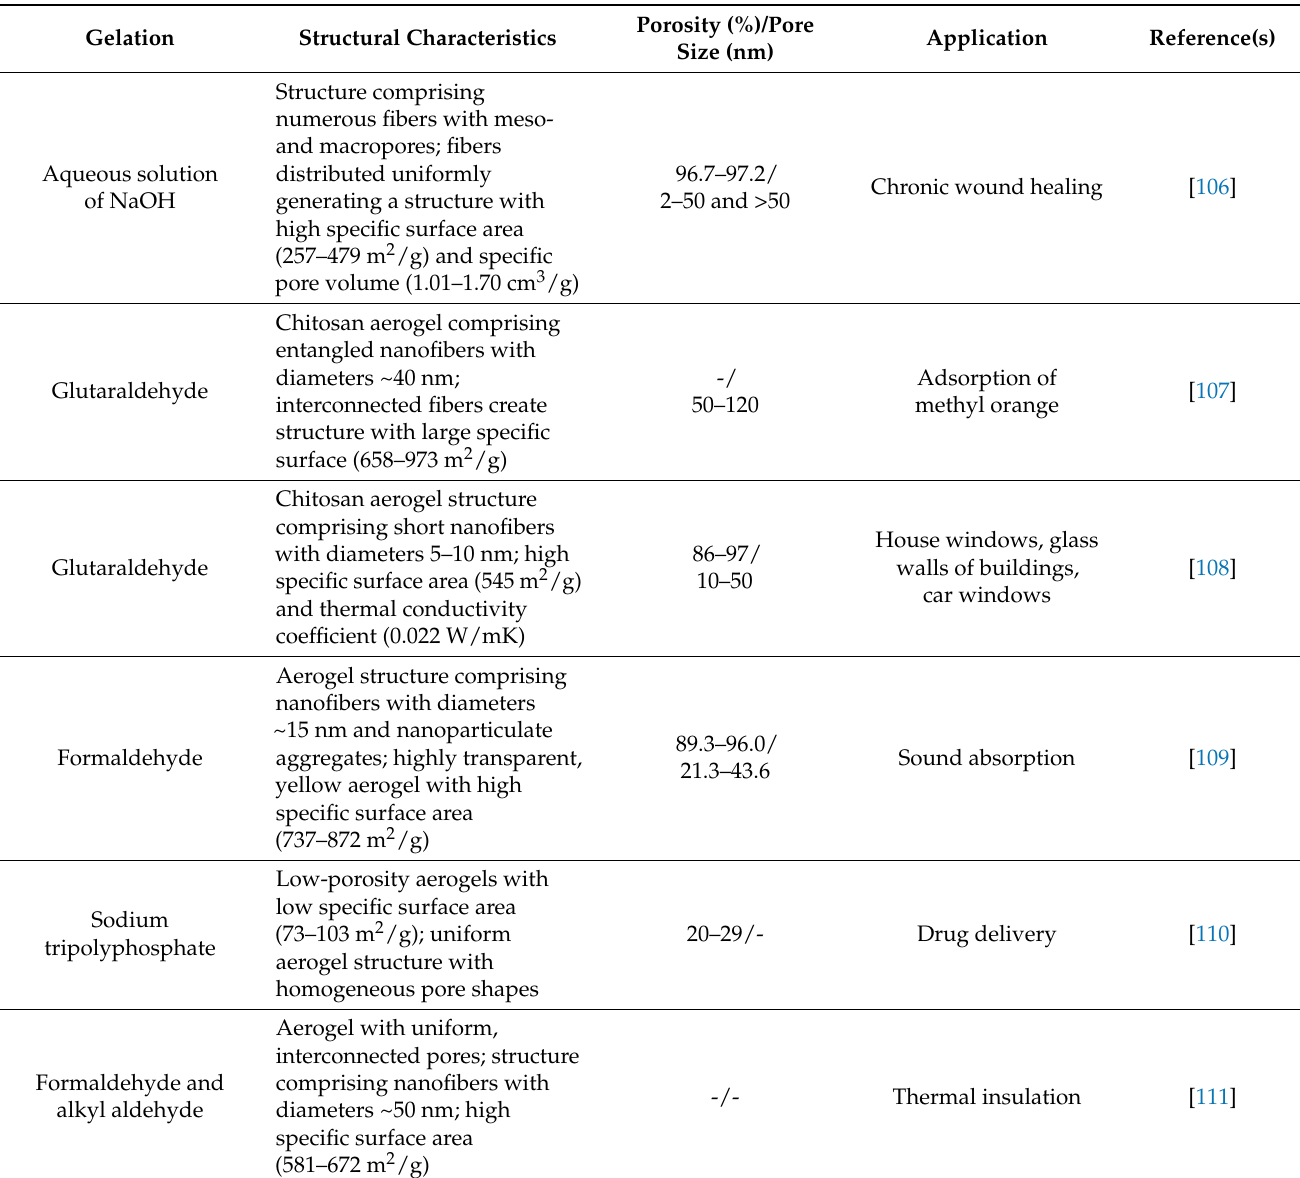
Table 2. Structural properties and application of chitosan aerogels prepared using scCO 2